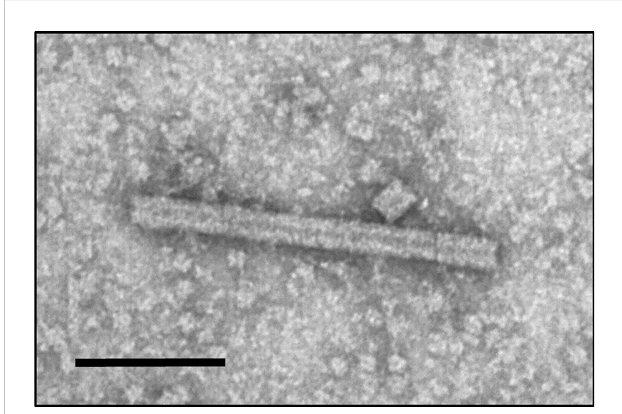
FIGURE 3 Plant-produced TMVc assemble into nanorod structures. The modi fi ed TMVc self-assembles into nanorod structures of varying lengths. Scale bar represents 100 nm. The protein sample was targeted to the apoplast and sampled on 7 dpi. Partially puri fi ed VLP extract was negatively stained and examined using a TEM (JEM-1400, JEOL) operated at 80